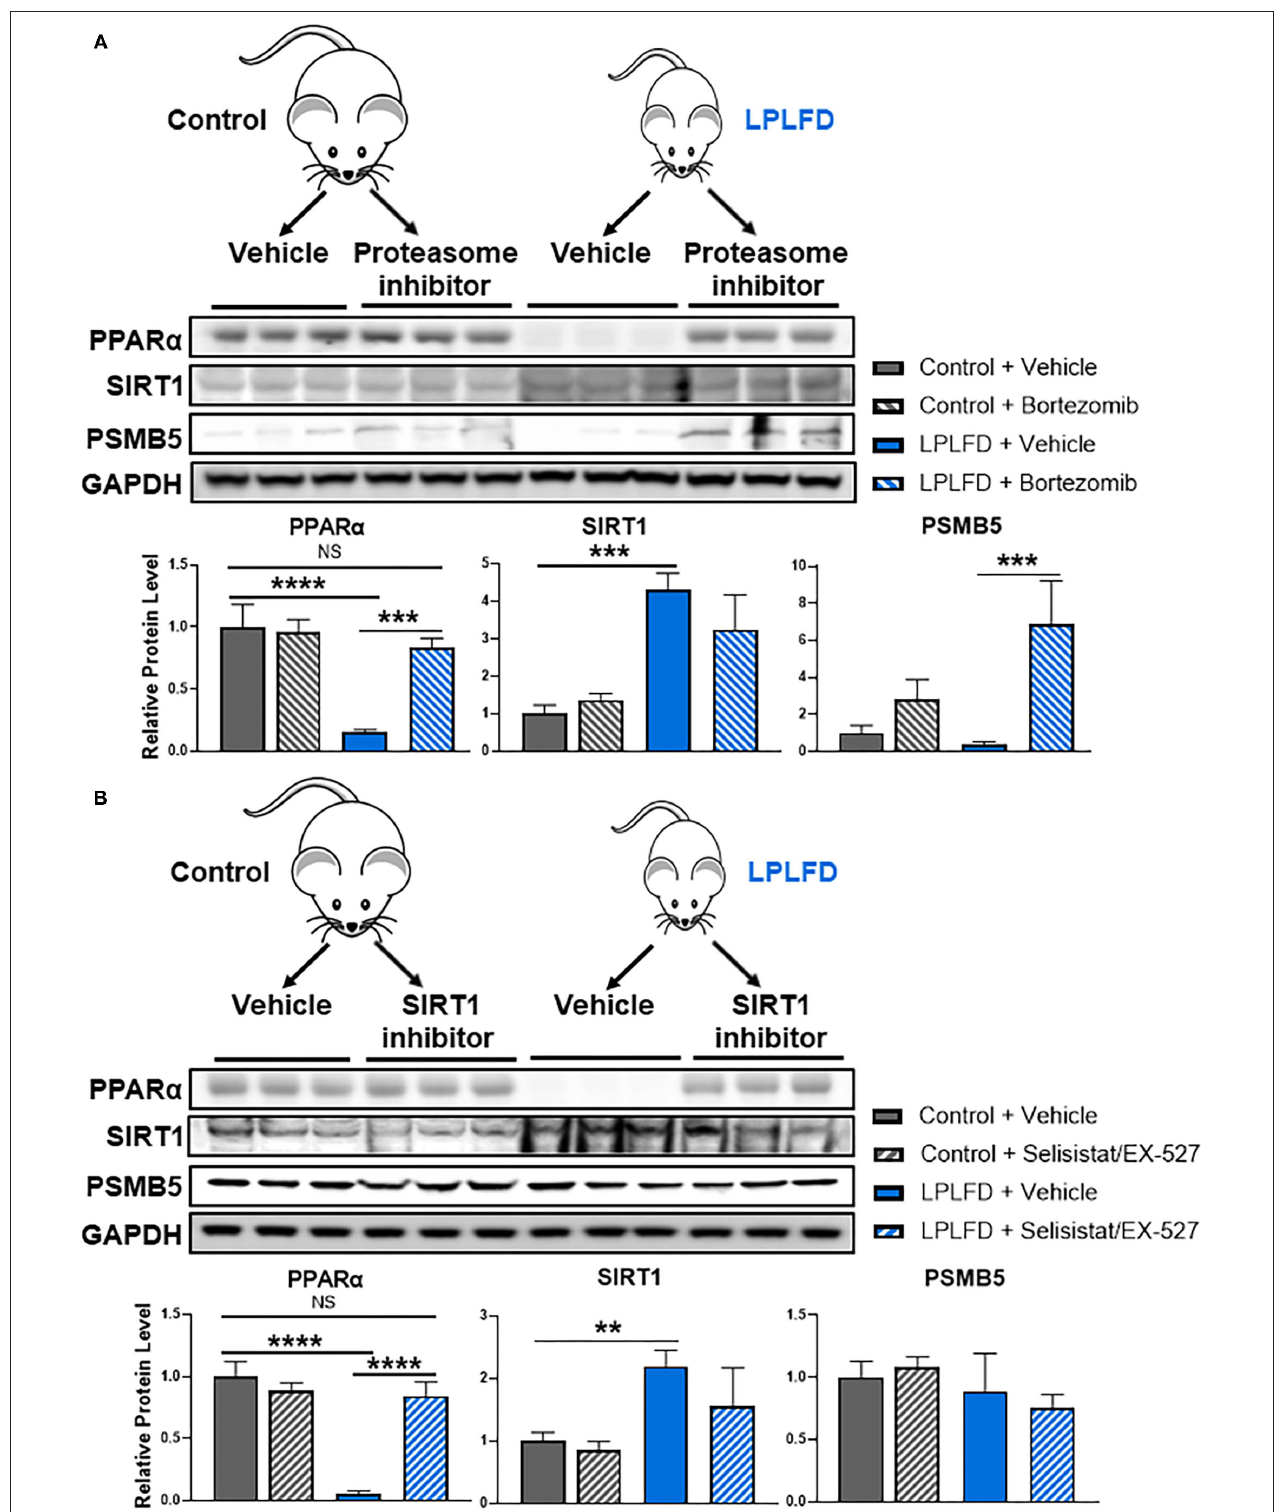
FIGURE 4 | Rescue of hepatic PPAR α by blocking SIRT1-mediated proteasomal degradation in undernourished mice. (A) Eight-week-old control and undernourished male mice were treated with a single intraperitoneal injection of 1 mg/kg of the proteasome inhibitor bortezomib, or an equivalent volume of sterile PBS, and after